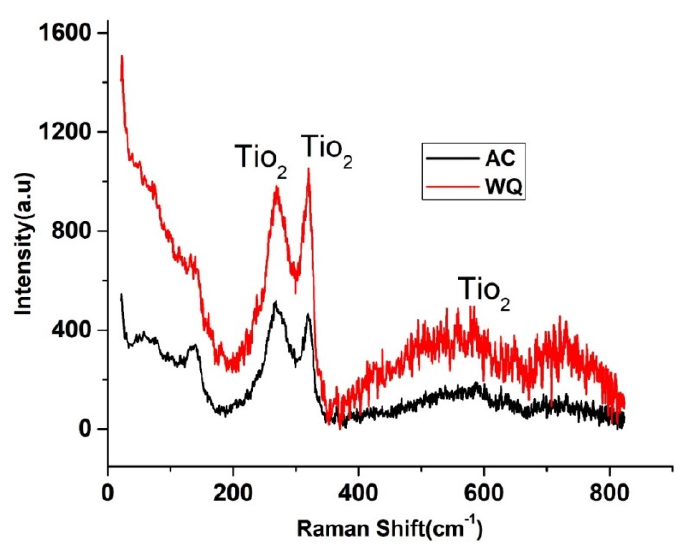
Figure 7. Raman spectra of WQ (upper) and AC specimens (lower).